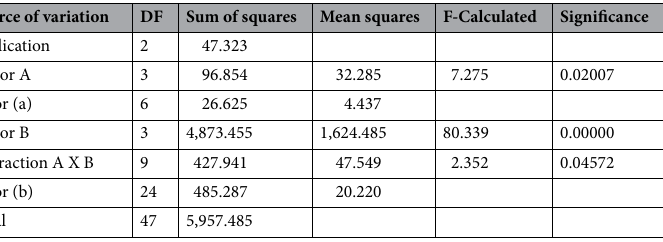
Table 13. Analysis of variance for effect of operating parameters on shredding efficiency. Factors A and B combine horizontal & vertical clearance and forward speed, respectively.